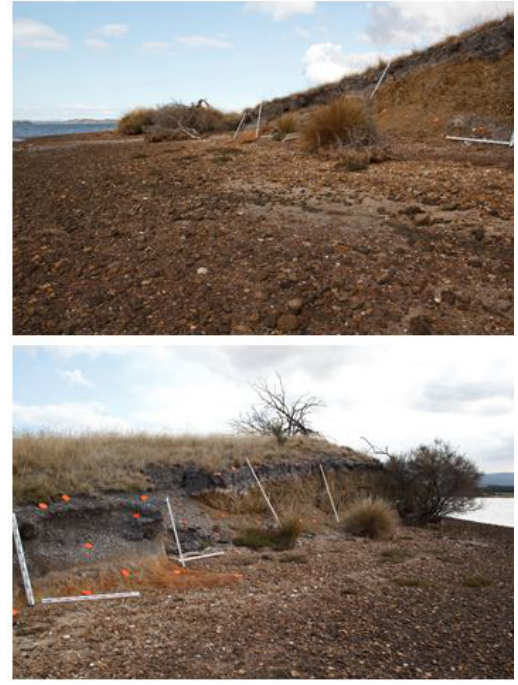
Figure 3: Images of the focus site (the first is taken looking east, the second is taken looking